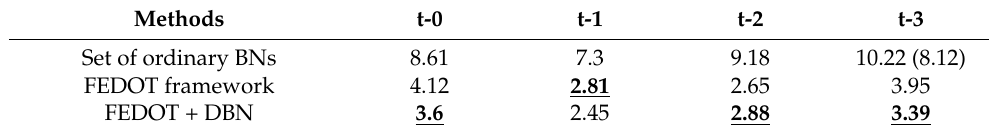
Table 7. Metrics of three methods in the task of predicting length of stay. Methods